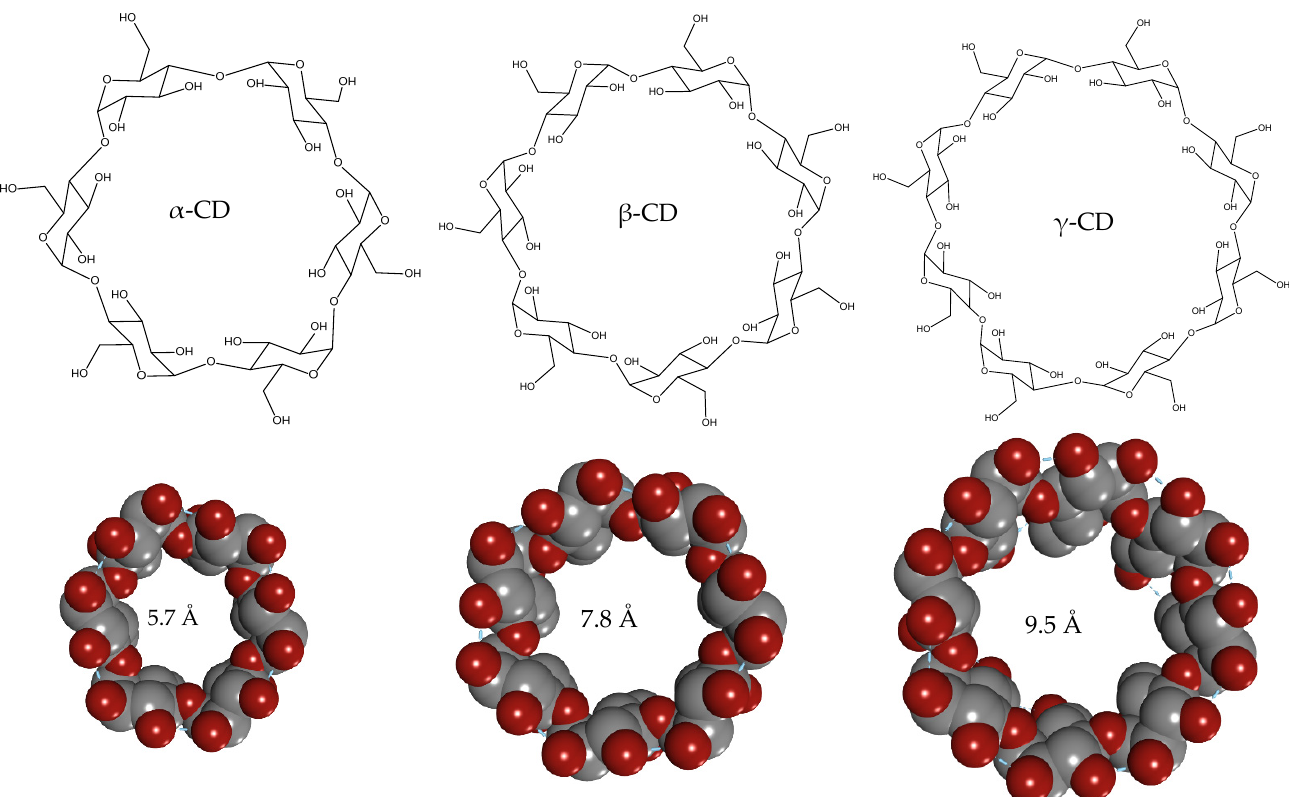
Figure 1. Structure and conformation of natural CDs.